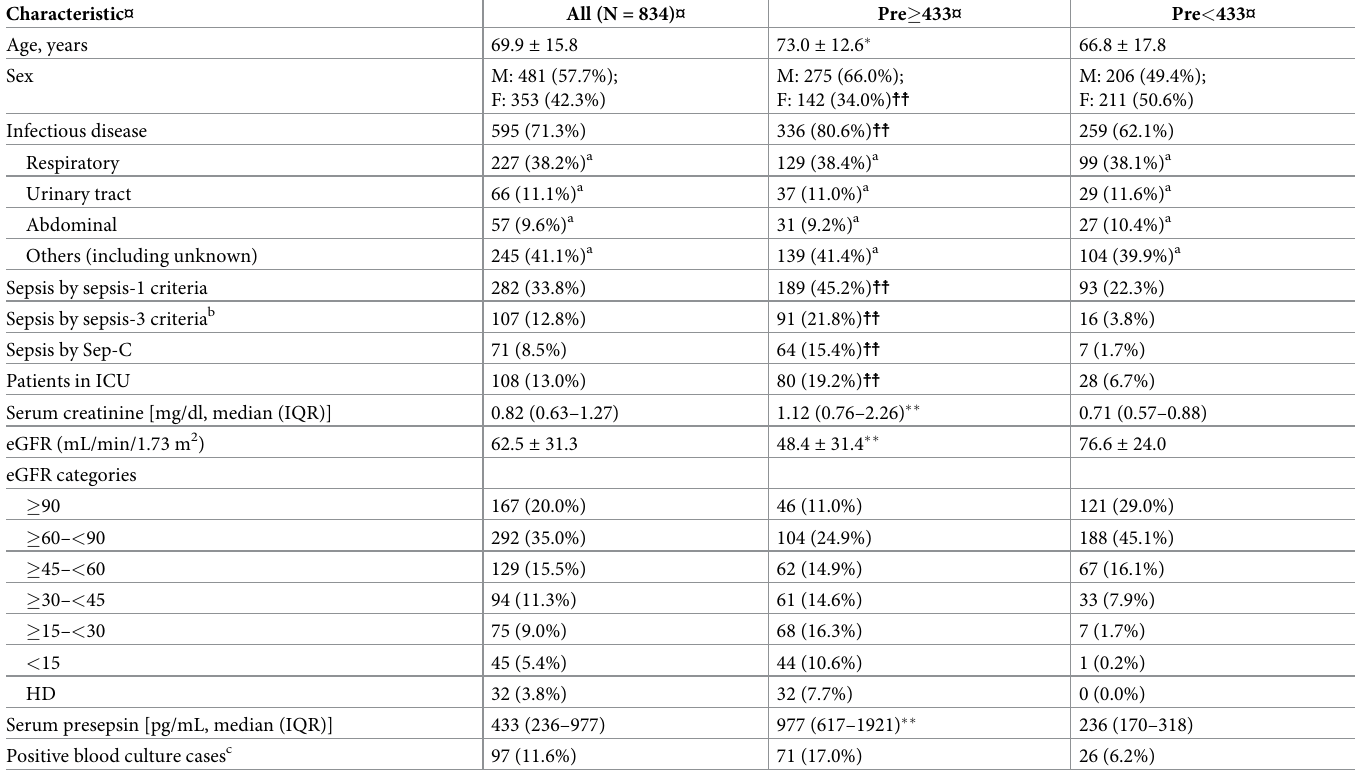
Table 1. Clinical characteristics of the patients (overall and divided by the median Pre